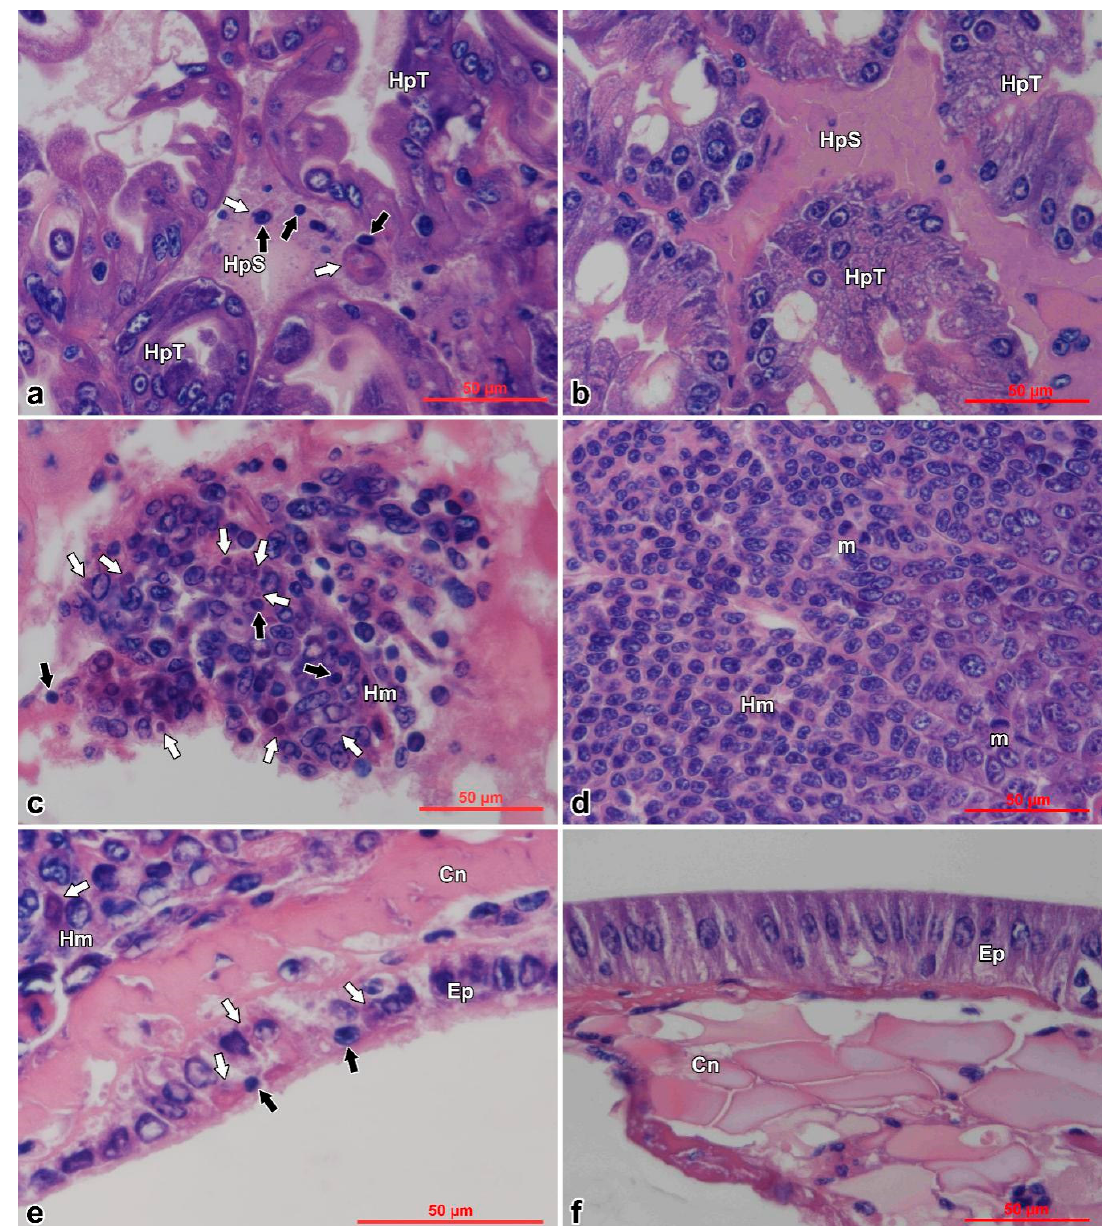
Figure 4. Histopathological examination of Exopalaemon carinicauda tissues infected with DIV1 and controls. Black arrows show karyopyknosis and white arrows show eosinophilic inclusions. Pictures ( a ) and ( b ) are hepatopancreas; ( c ) and ( d ) are hematopoietic tissues; and ( e ) and ( f ) are cuticular epithelium on which the cuticles were removed before dehydration. The pictures in the left column (a, c, and e) are the tissues of the infected prawn; the pictures in the right column (b, d, and f) are the tissues of the control prawn. HpT: hepatopancreatic tubule; HpS: hepatopancreatic sinus; Hm: hematopoietic tissue; Ep: epithelium; Cn: connective tissue; m: mitotic phase. Bar = 50 µ m.